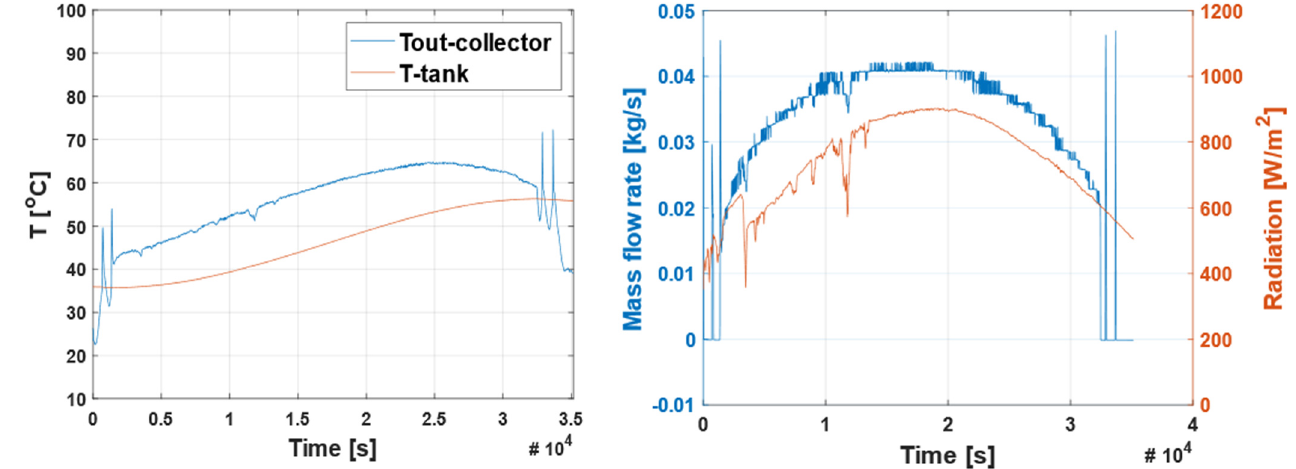
Figure 18. Measurement results of 22.05.